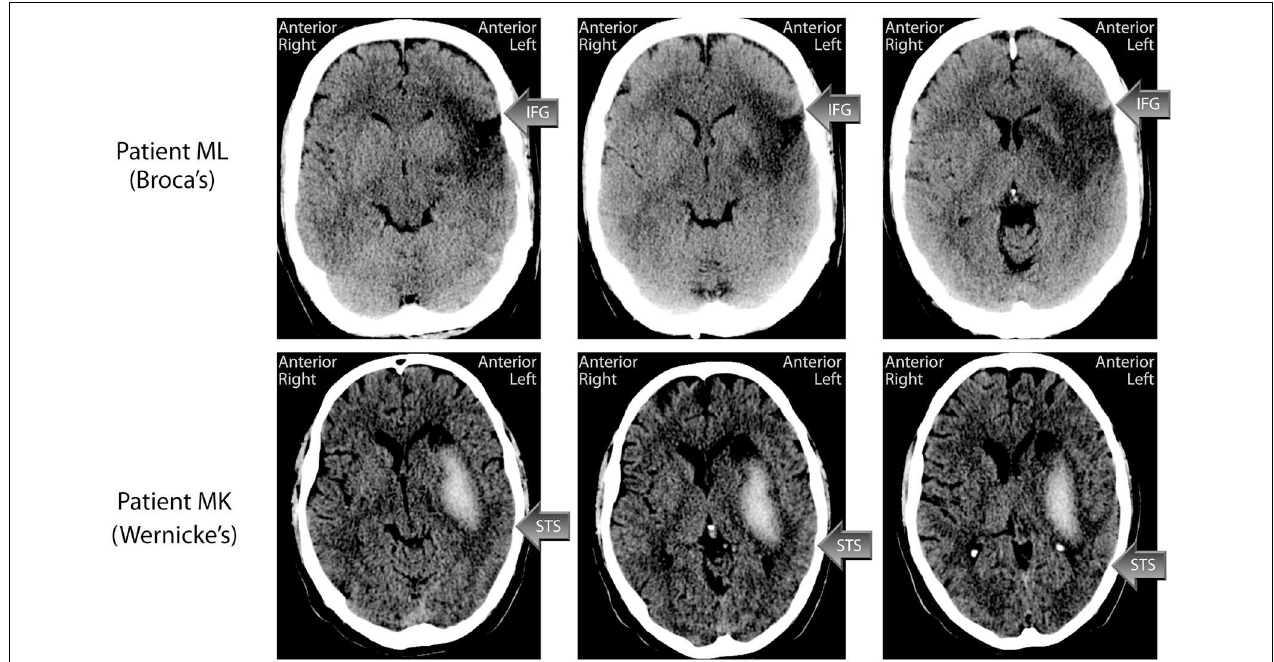
FIGURE 1 | CT-scans of the lesions of patients ML (Broca’s aphasic) and MK (Wernicke’s aphasic). Arrows indicate the approximate location of the inferior frontal gyrus (IFG) in Patient ML and the superior temporal sulcus (STS) in Patient MK. See main text for a description of the patients’ lesions.